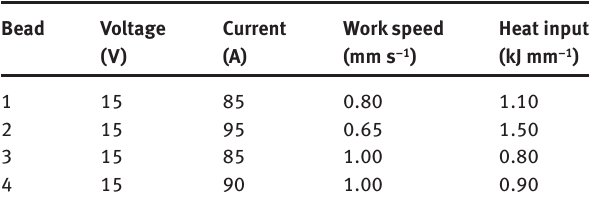
Table 3: Welding parameters used for the HP-Nb and HP-NbTi